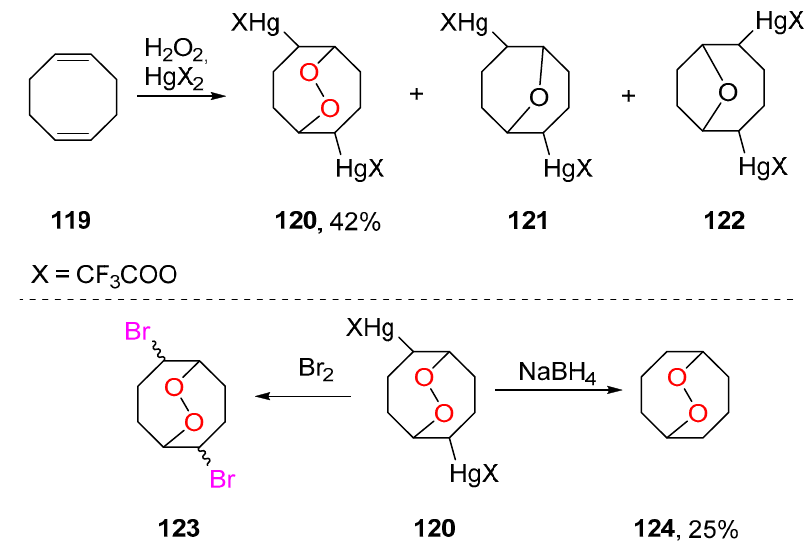
Scheme 42. Synthesis of bicyclic peroxides 120 , 123 and 124 .